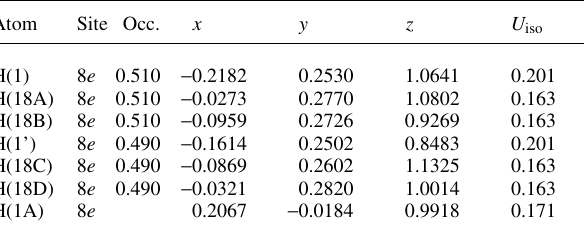
Table 2. Atomic coordinates and displacement parameters (in Å 2 ) .